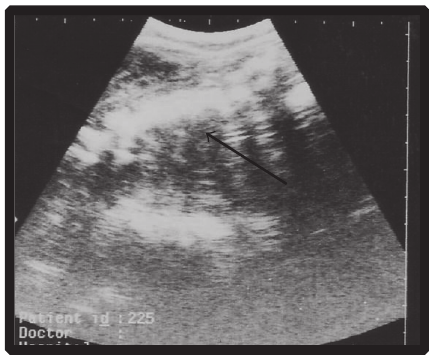
Figure 2: Single dead fetus at 120 days of gestation (arrow).